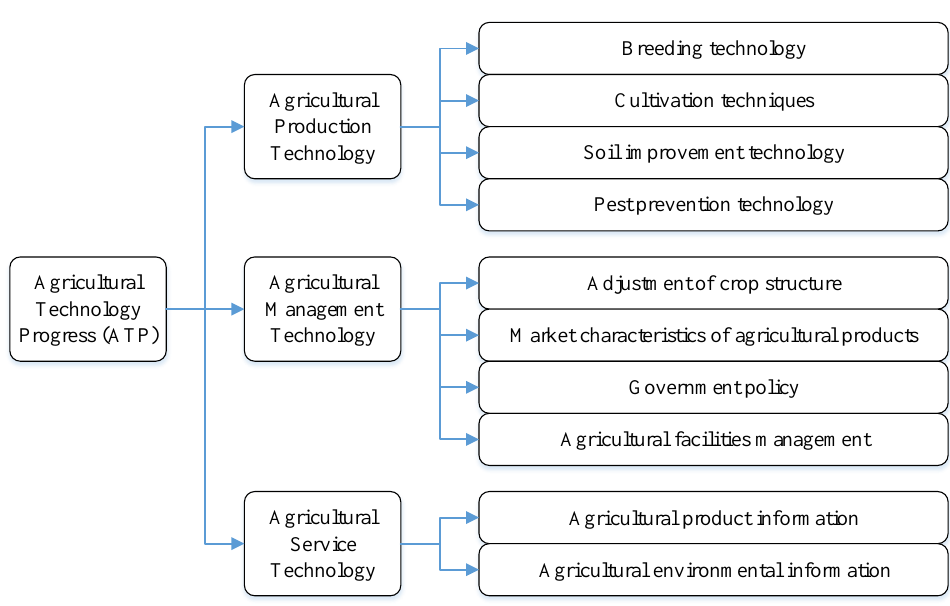
Figure 1. The composition of agricultural technology